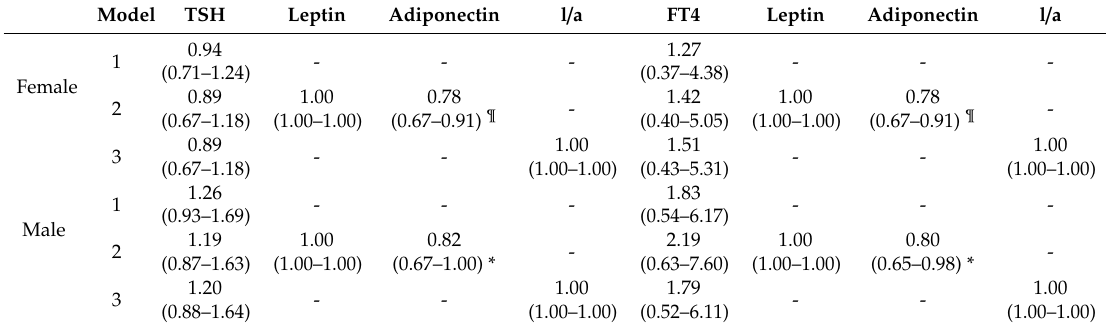
Table 5. E ff ect of thyroid hormones and cytokine of metabolic syndrome: results of logistic